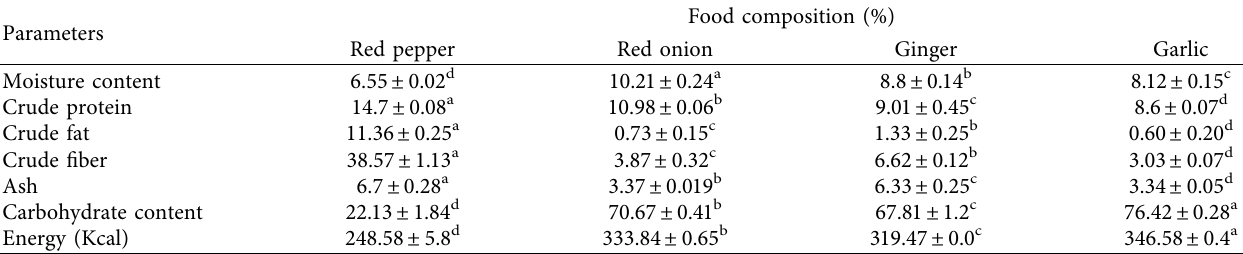
Food composition (%)